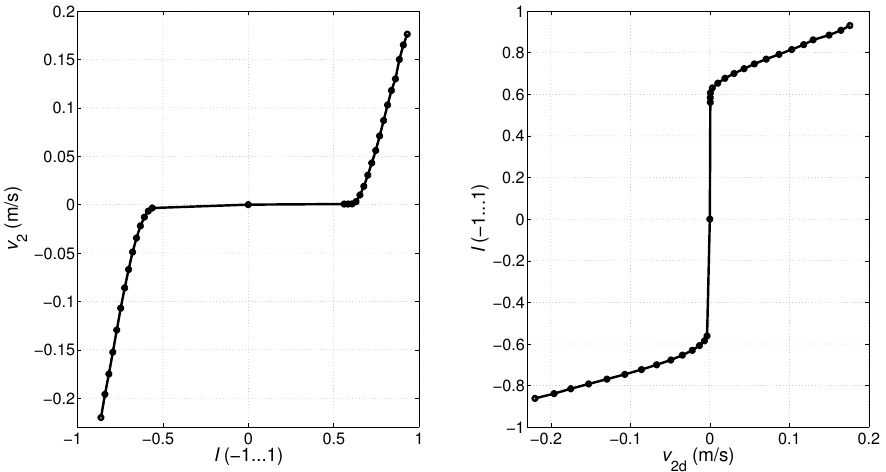
Figure A1. Determination of the feed-forward function: the measured lift velocities versus the valve control are illustrated on the left, the inverted feed-forward function DZI is illustrated on the right. The data point pairs can be matched by using a constant valve input to determine the steady-state cylinder velocity. The cylinder velocities in between the measured points can be interpolated using